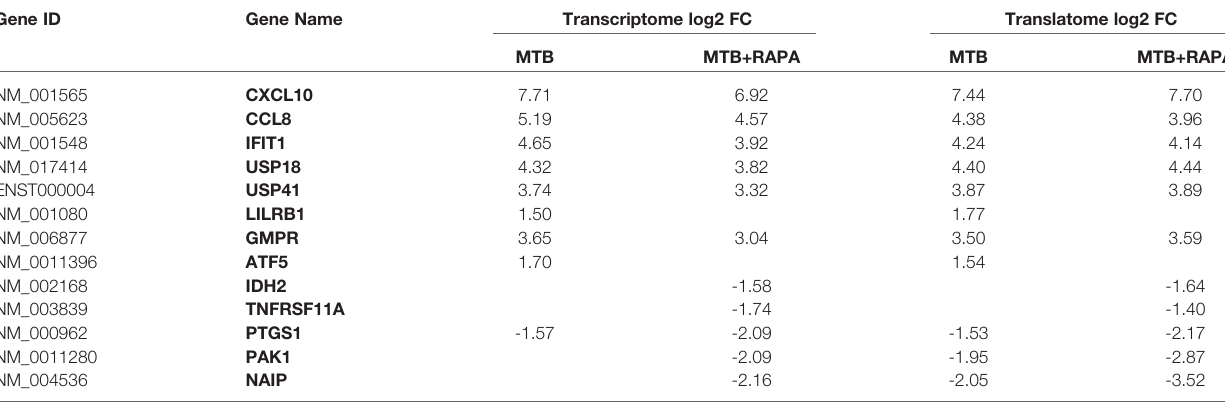
GENES DOWN-REGULATED BY RAPAMYCIN IN MTB-INFECTED DC AT TRANSCRIPTOME